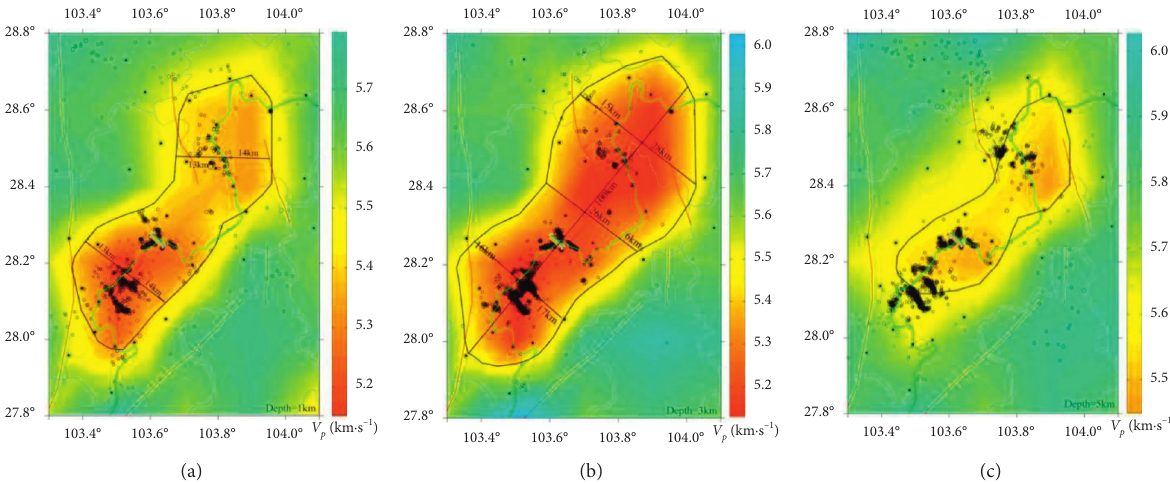
Figure 6: Inversion results based on crustal P -wave velocity (a) at 1 km depth (depth of small earthquake: 0.0–1.9km); (b) at 3km depth (depth of small earthquake: 2.0–3.9 km); (c) at 5 km depth (depth of small earthquake: 4.0–5.9km).